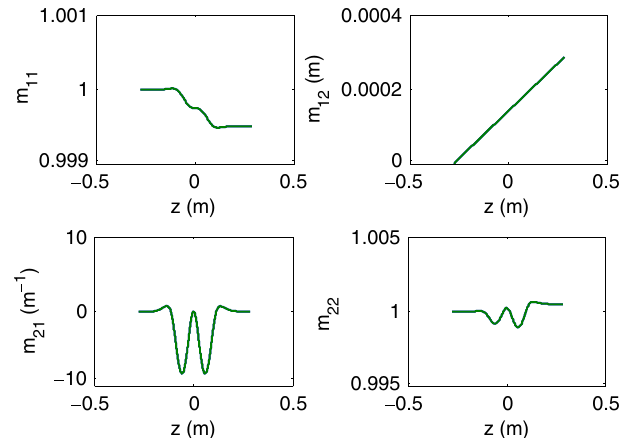
FIG. 9. Comparison of the general algorithm to the ‘‘ (cid:5) ¼ 1 ’’ algorithm.